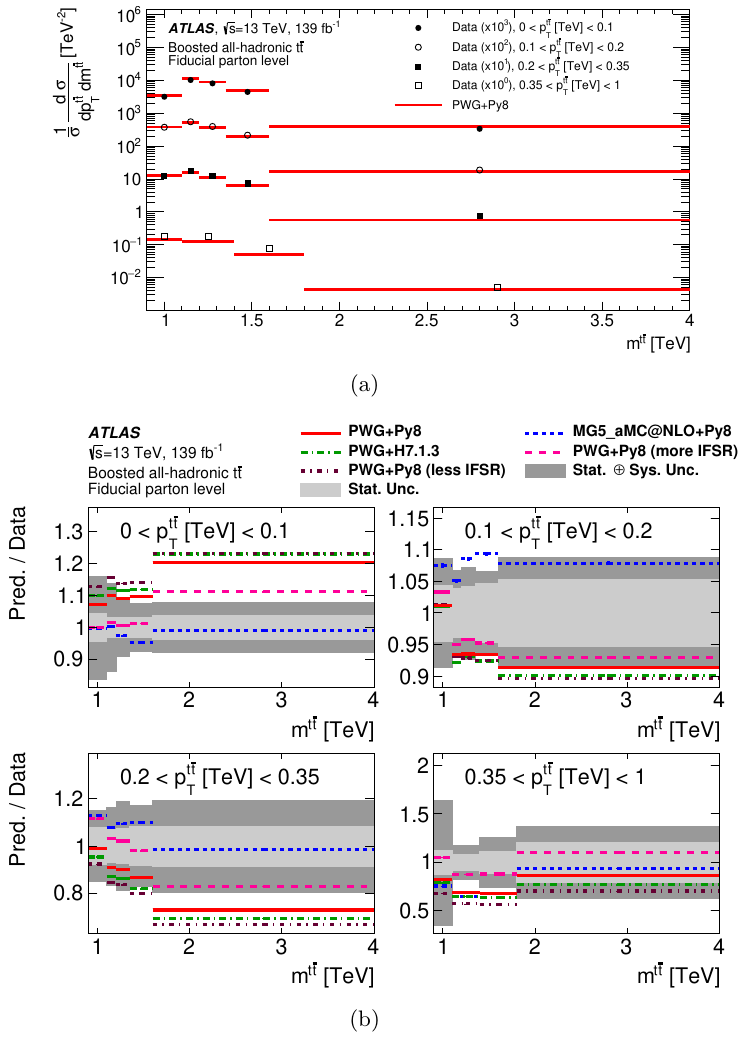
Figure 30 . (a) Normalized parton-level fiducial phase-space double-differential cross-sections as a function of the p T and the mass of the t ¯ t system, p t ¯ t and m t ¯ t , compared with the T Powheg+Pythia 8 calculation. Data points are placed at the centre of each bin and the Powheg+Pythia 8 calculation is indicated by solid lines. The measurement and the prediction are normalized by the factors shown in parentheses to aid visibility. (b) The ratios of various MC calculations to the normalized parton-level fiducial phase-space differential cross-sections. The dark and light grey bands indicate the total uncertainty and the statistical uncertainty, respectively, of the data in each